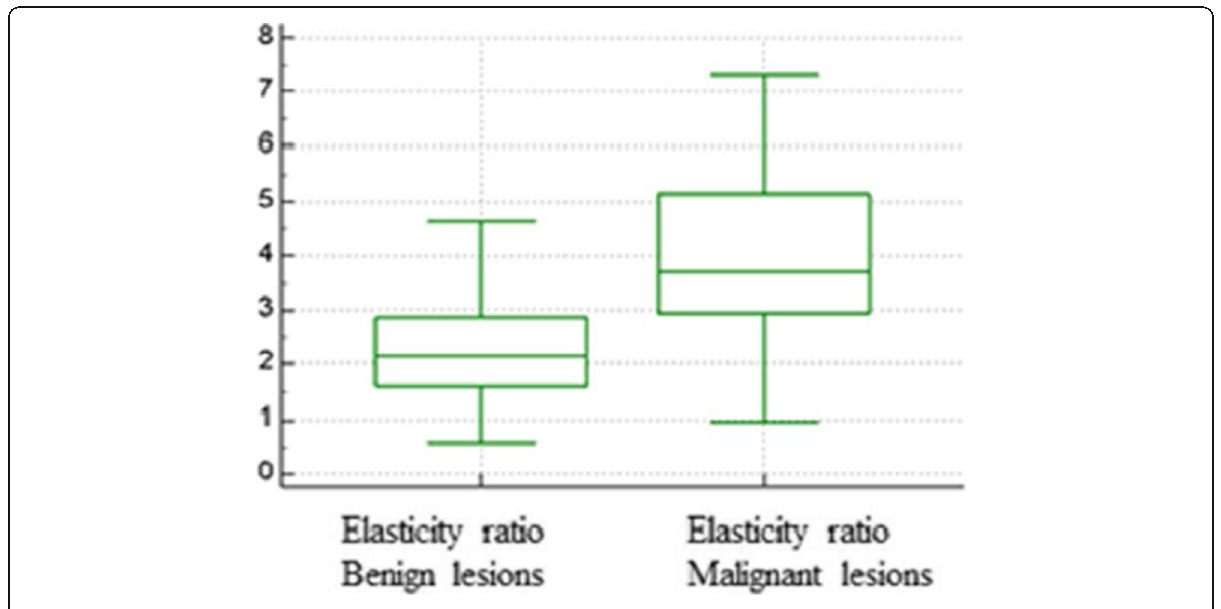
Fig. 9 Elastic ratio of malignant and benign mass